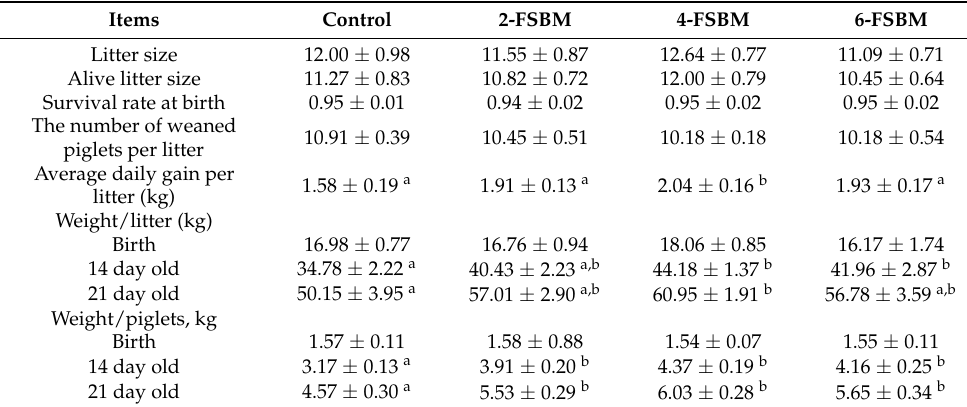
Table 3. The performance of sows and their litter in different dietary groups.